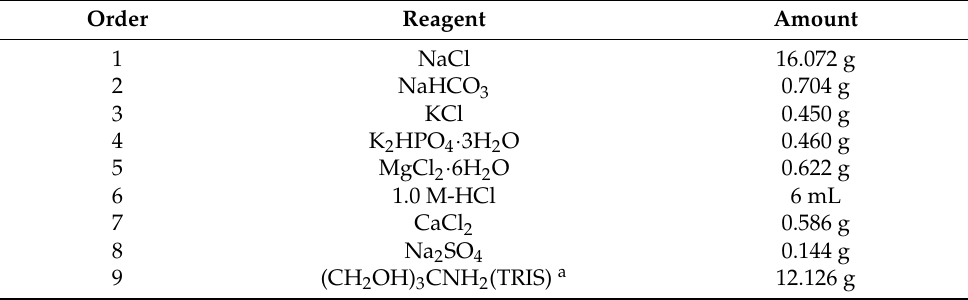
Table 2. Reagents for preparation of SBF (pH 7.30–7.40, 2000 mL).